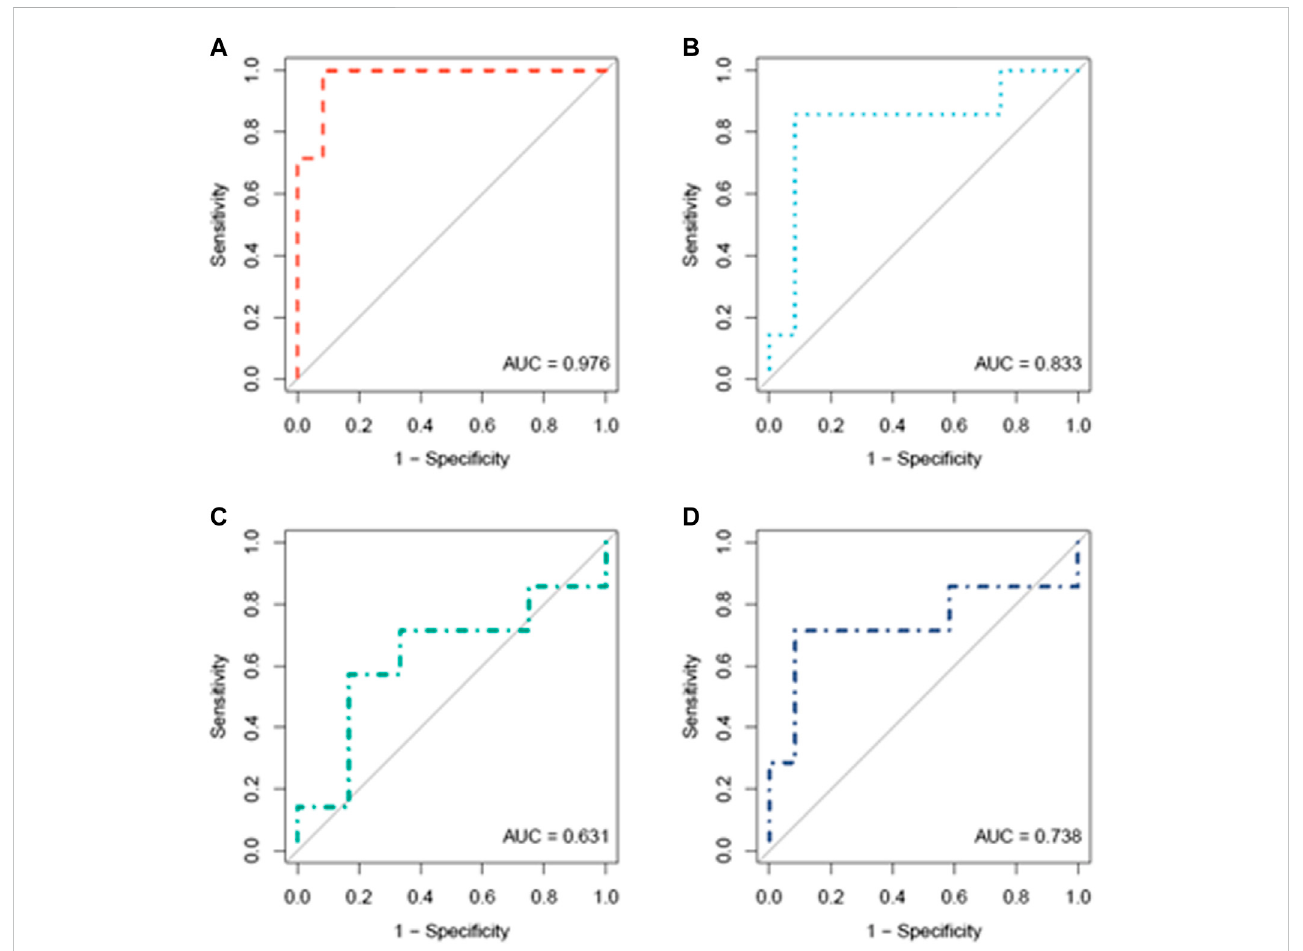
FIGURE 4 ROC curve analysis of CAIX (A) , sFlt1 (B) , PlGF (C) , and sFlt1/PlGF (D) in women who later developed the pathology ( n = 7) compared to women who did not ( n = 12) at a gestational age ranging from 28 to 32 weeks.